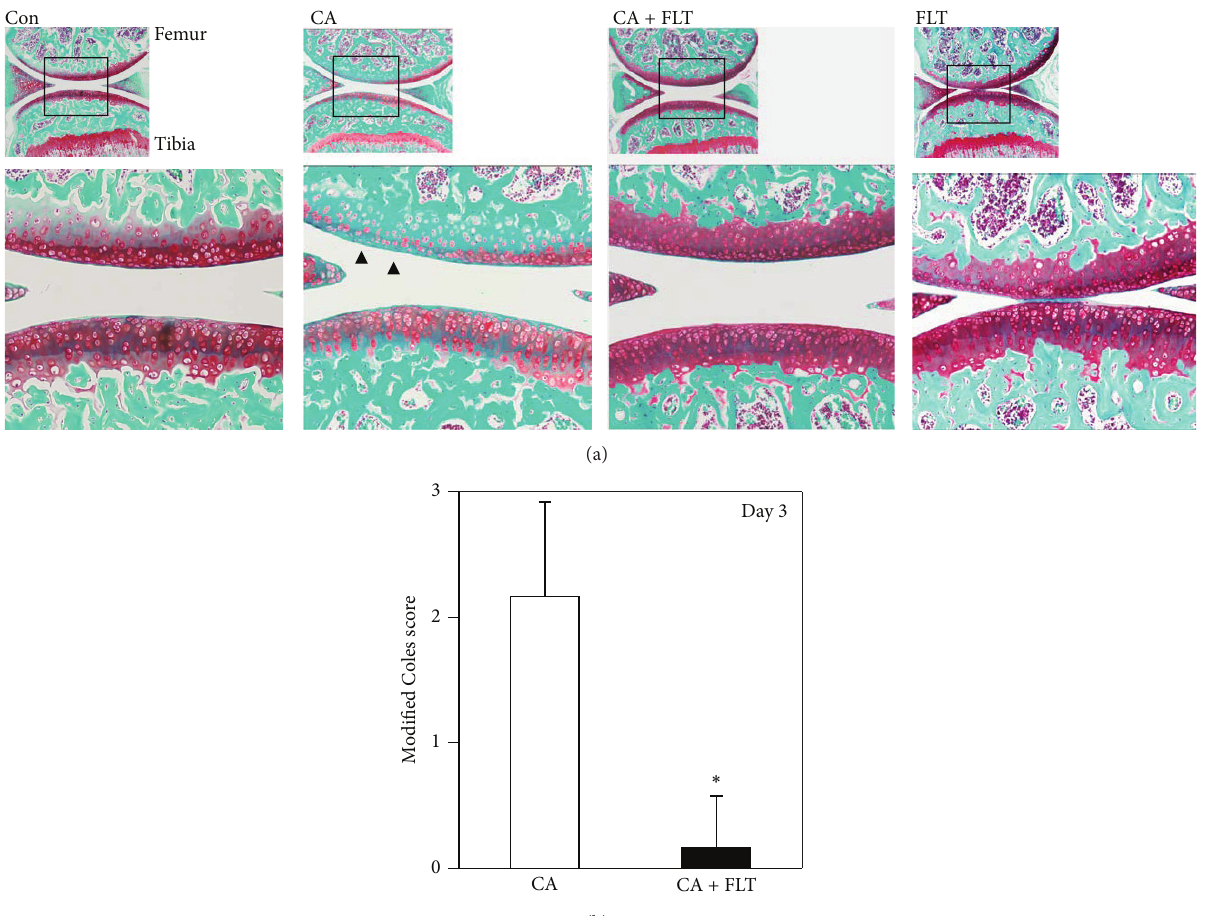
Figure 3: Histological analyses of articular cartilage degeneration induced by carrageenan at day 3. (a) Safranin-O staining of sagittal sections of mice knee joints at day 3 after carrageenan injection. Boxed areas in the top panels are magnified and presented in the bottom panels. CA: carrageenan group; CA + FLT: carrageenan + follistatin group; Con: control group; FLT: follistatin group. Magnification: top × 40, bottom × 100. Arrowhead indicates the region where proteoglycan erosion is observed. (b) Semiquantitative analyses of articular cartilage degeneration. The degree of articular cartilage degeneration was semiquantitatively evaluated ( Modified Coles Score ( Coles et al., Arthritis & Rheumatology, 2010 )) [19]. Histological scores of articular cartilage from femurs and tibiae were evaluated, respectively, and total scores were compared between the two groups ( ∗ 𝑃 < 0.05)